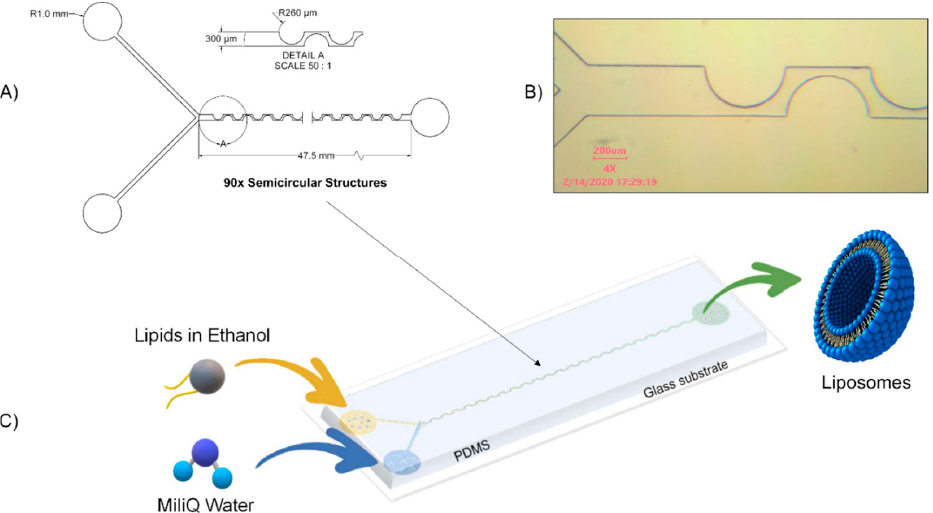
Figure 1. Periodic Disturbance Micromixer. ( A ) Microchannel dimensions. ( B ) Microscope image of the Periodic Disturbance Micromixer (PDM) device. ( C ) Schematic representation of the liposome formation process, lipids diluted in ethanol are injected in one inlet, while MiliQ water is injected in the second inlet. After passing through the mixing channel, liposomes are collected at the outlet.